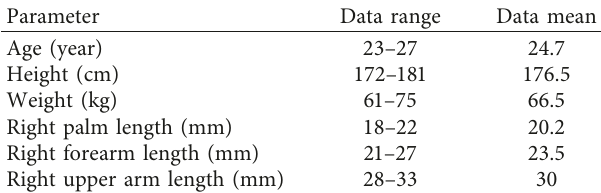
Table1: The anthropometric data of subjects.